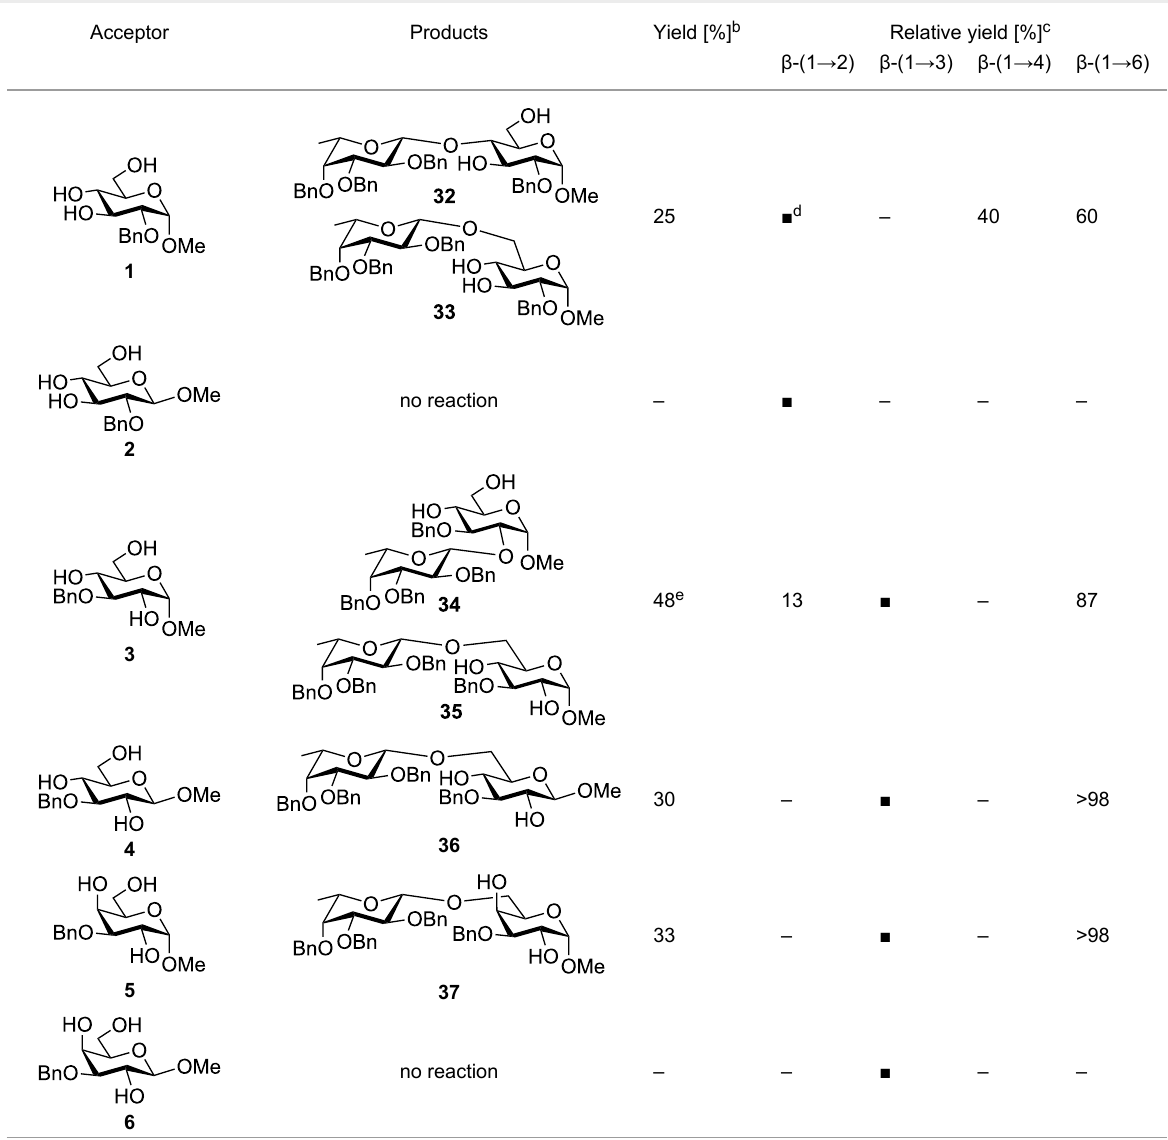
Table 1: Glycosylation results for acceptors 1 – 6 with NaH as base and 2,3,4-tri- O -methyl- α -L-fucopyranosyl chloride (Fuc-Cl, 7 ) as donor.